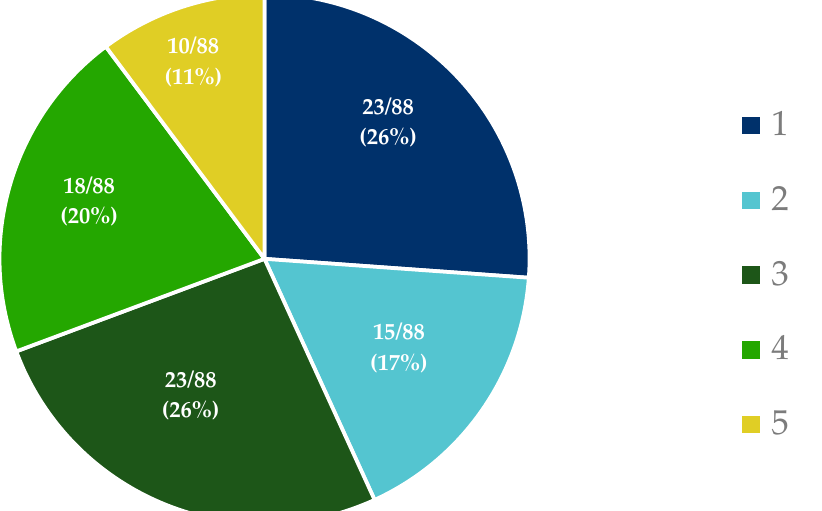
Figure 4. Participants’ understanding of terminology. Responses to the workshop poll question on a scale from 1 (low) to 5 (high), “How well do you understand the differences between controlled vocabulary, thesaurus, and ontology and when to use one versus the other?”